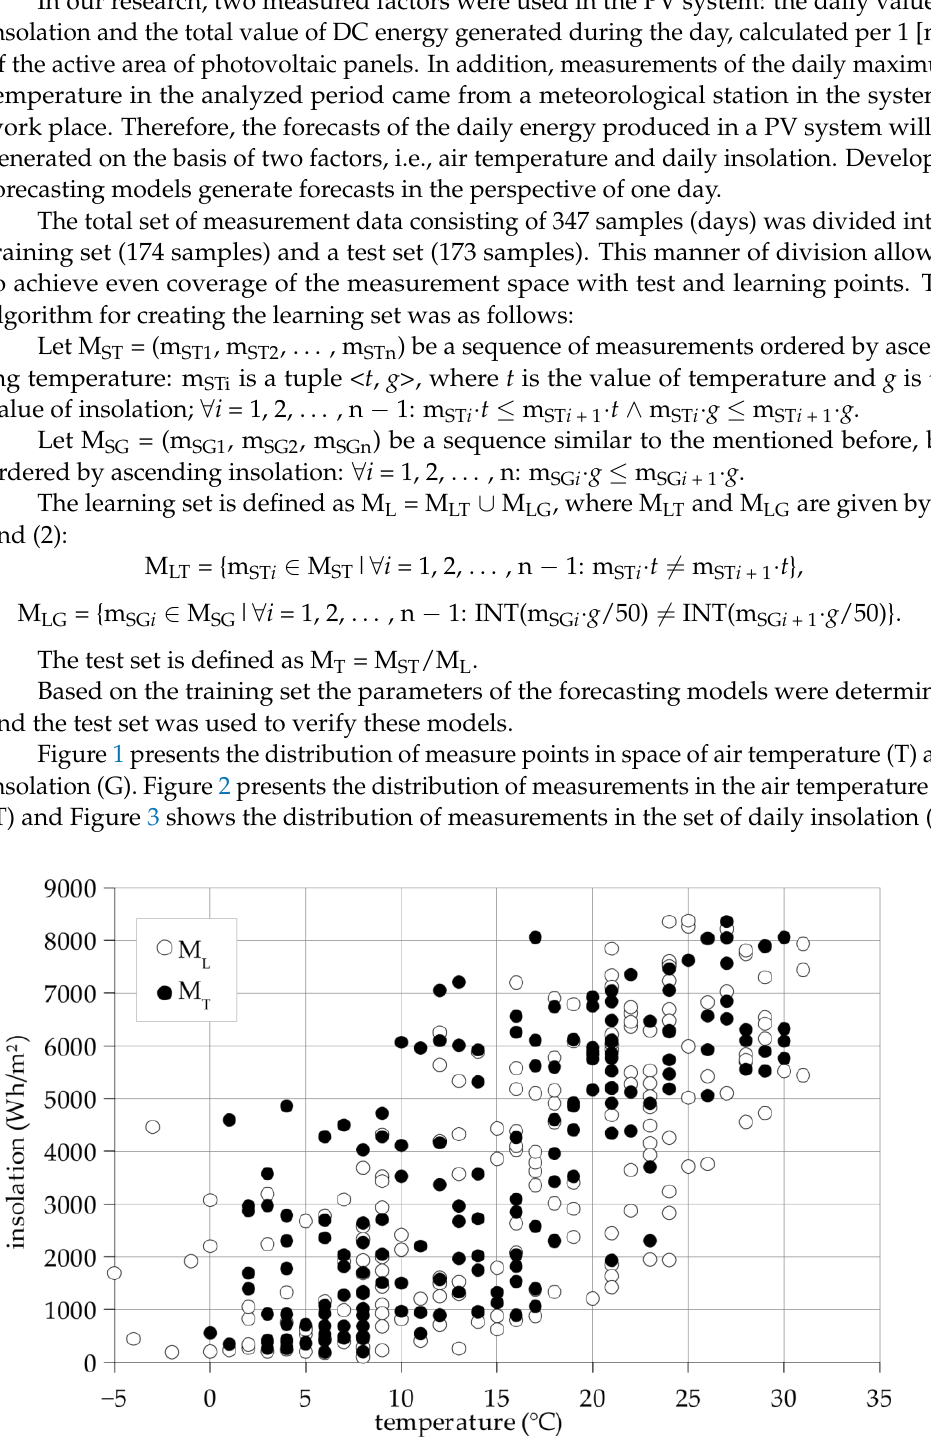
Figure 1. Distribution of measurement points (M T —test, M L —learning) in the space of temperature T and insolation G, T × G.